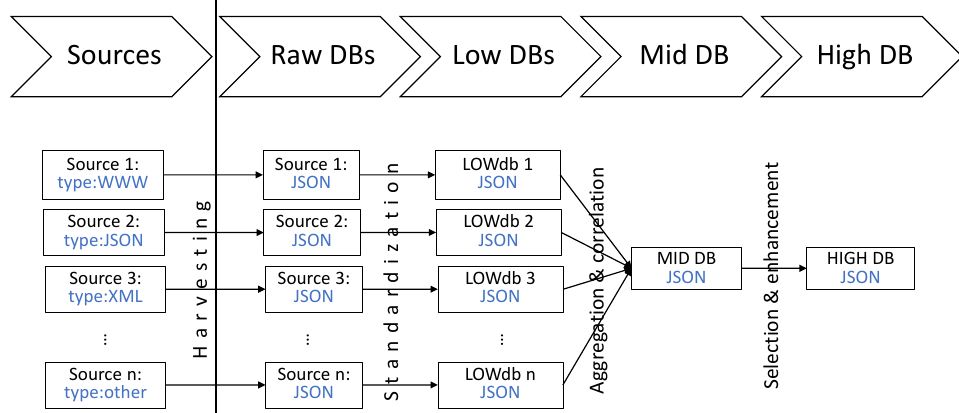
Figure 2. Architecture of DB and stages of processing